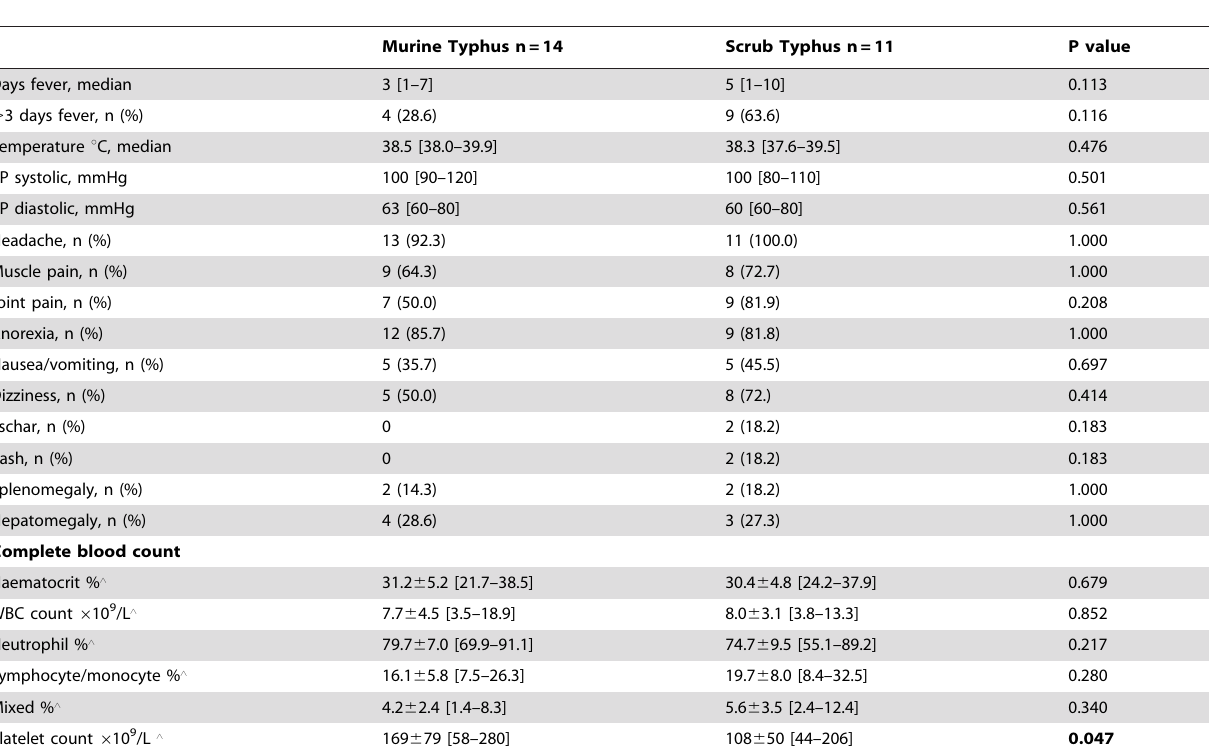
Table 2. SMRU fever cohort women clinical features and complete blood count on admission.